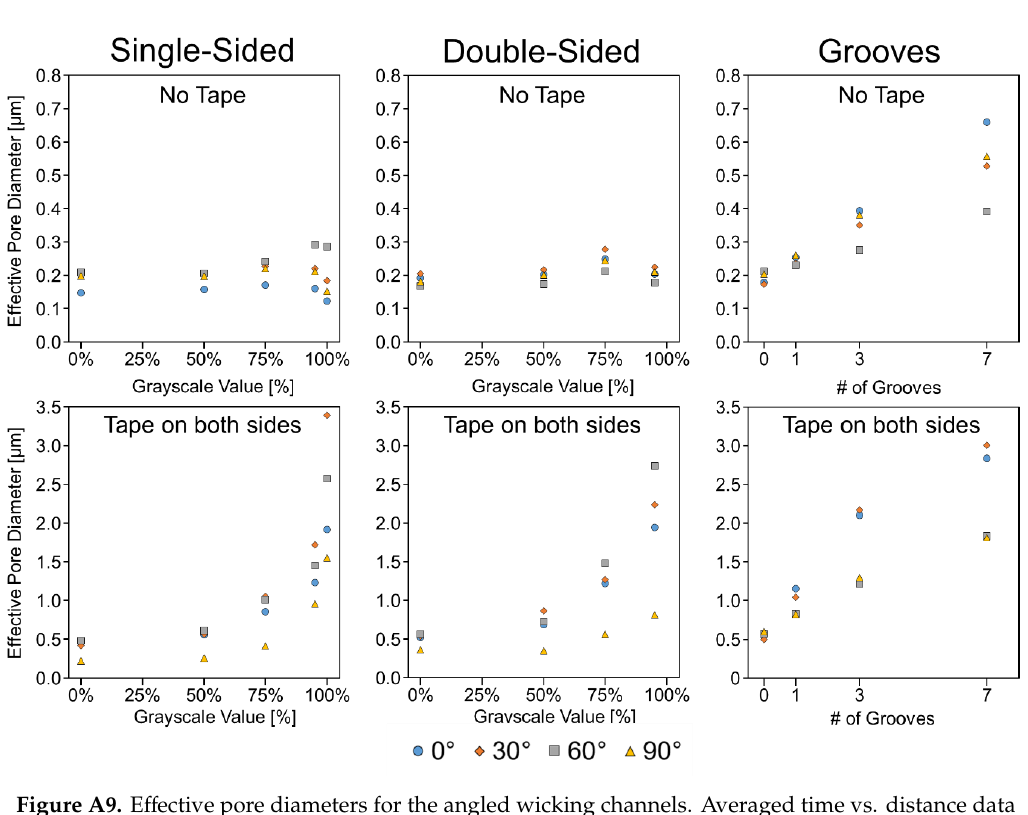
Figure A9. E ff ective pore diameters for the angled wicking channels. Averaged time vs. distance data from n = 5 (Figures A7 and A8) were fit to the modified Lucas–Washburn model (below) described by Camplisson et al. [26] using q 0 = 1.25 × 10 − 8 m / s, derived from using an evaporative flux, F , of 2.5 × 10 − 5 kg / s · m 2 from Castro et al. [10], where F = 2 × q 0 ρ for the untaped channels and q 0 = 0 for the taped channels.